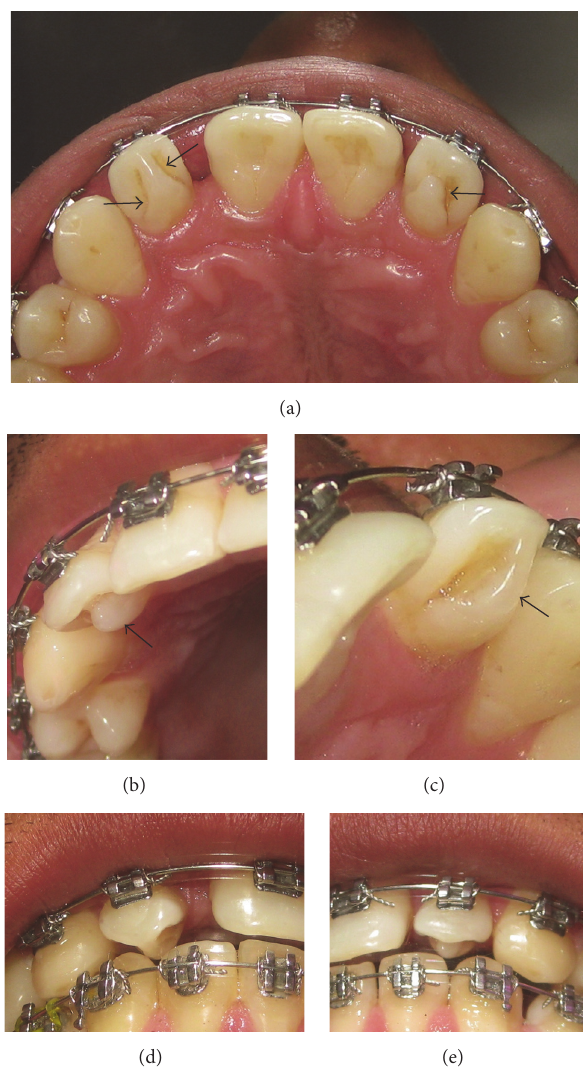
Figure 1: (a–c) Presence of complete Talon cusp (black arrows); (d, e) incisal view showing the contact of Talon cusp with the lower anterior teeth.